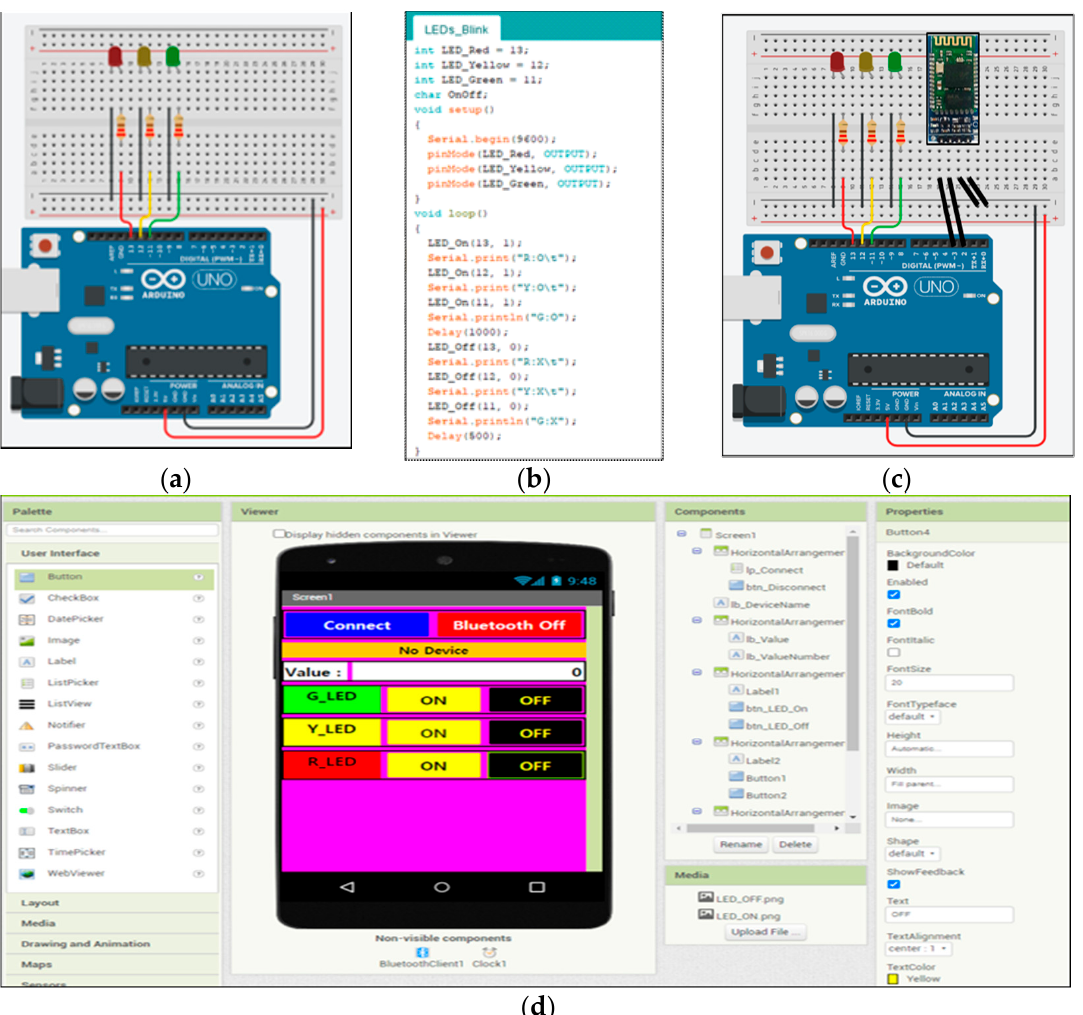
Figure 3. Learning contents for Arduino class, ( a ) is making an Arduino circuit in Tinkercad and Arduino kits, ( b ) is programming practice learning in the Arduino IDE, ( c ) is completing the circuit diagram by adding a Bluetooth module, ( d ) is making an IoT system prototype in App Inventor.